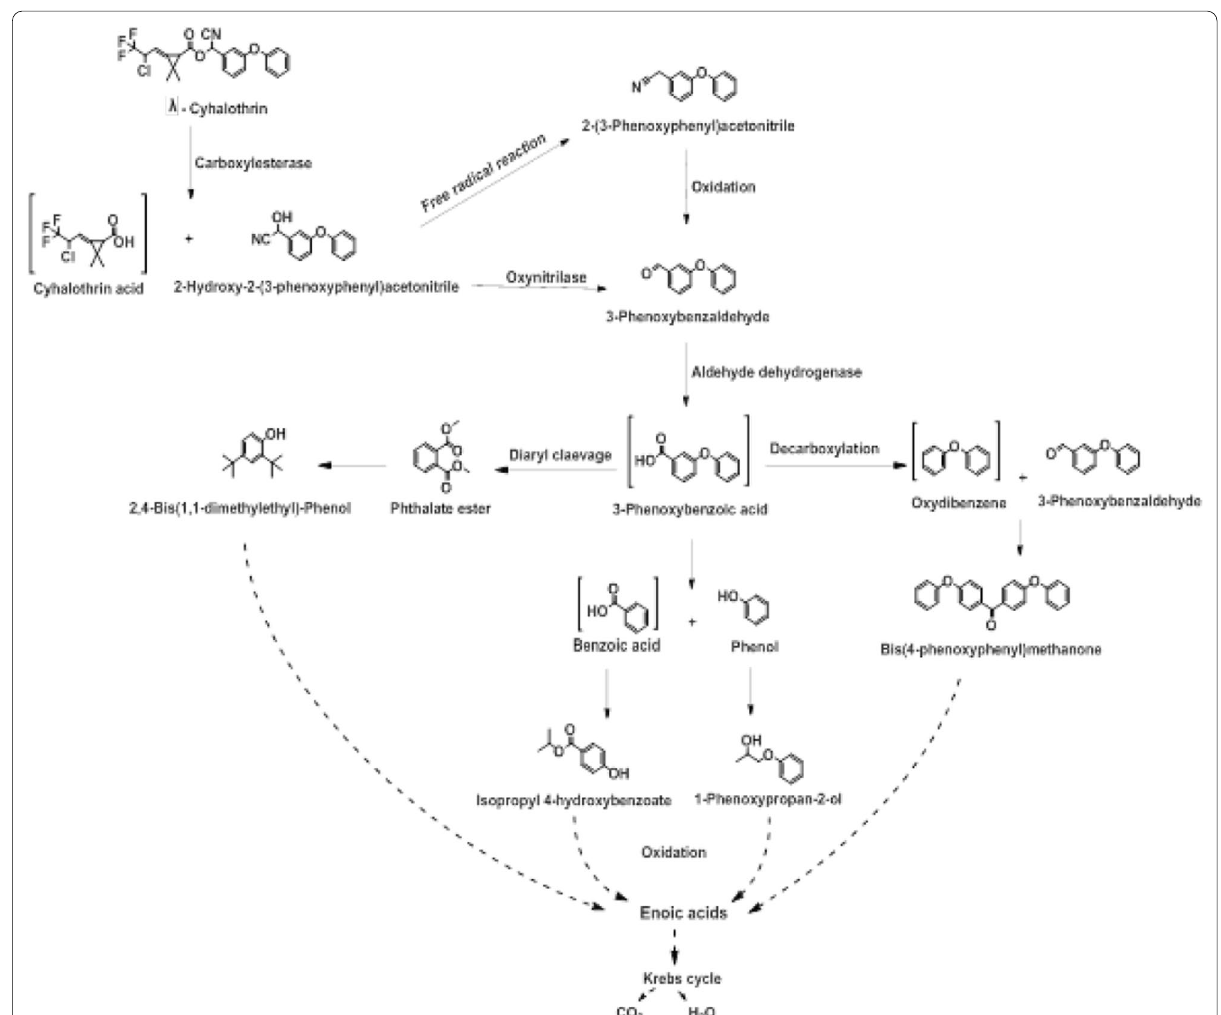
Fig. 2 Proposed λ-cyhalothrin biodegradation mechanism in Bacillus subtilis isolates based on the detected